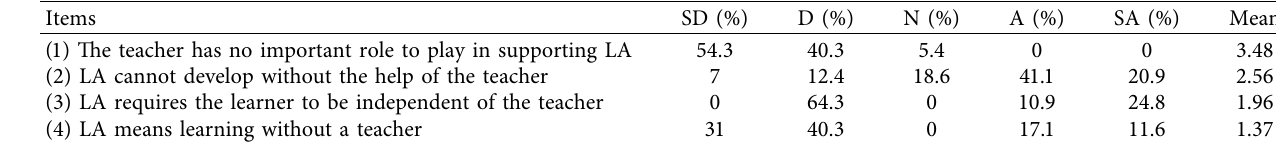
Table 8: Descriptive statistics of teacher roles in learner